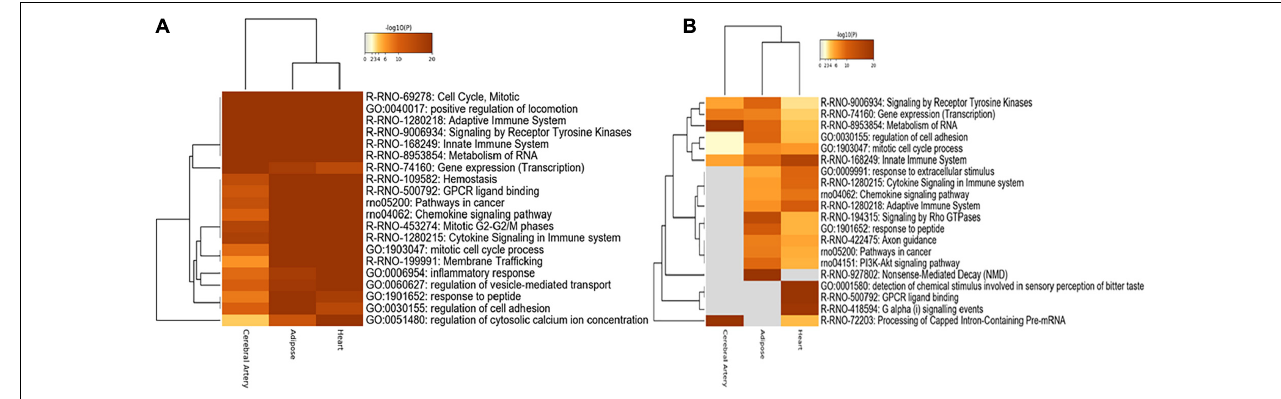
FIGURE 5 | Functional enrichment analysis. (A) Functional enrichment analysis of nonspecific genes. (B) Functional enrichment analysis of tissue-specific genes.